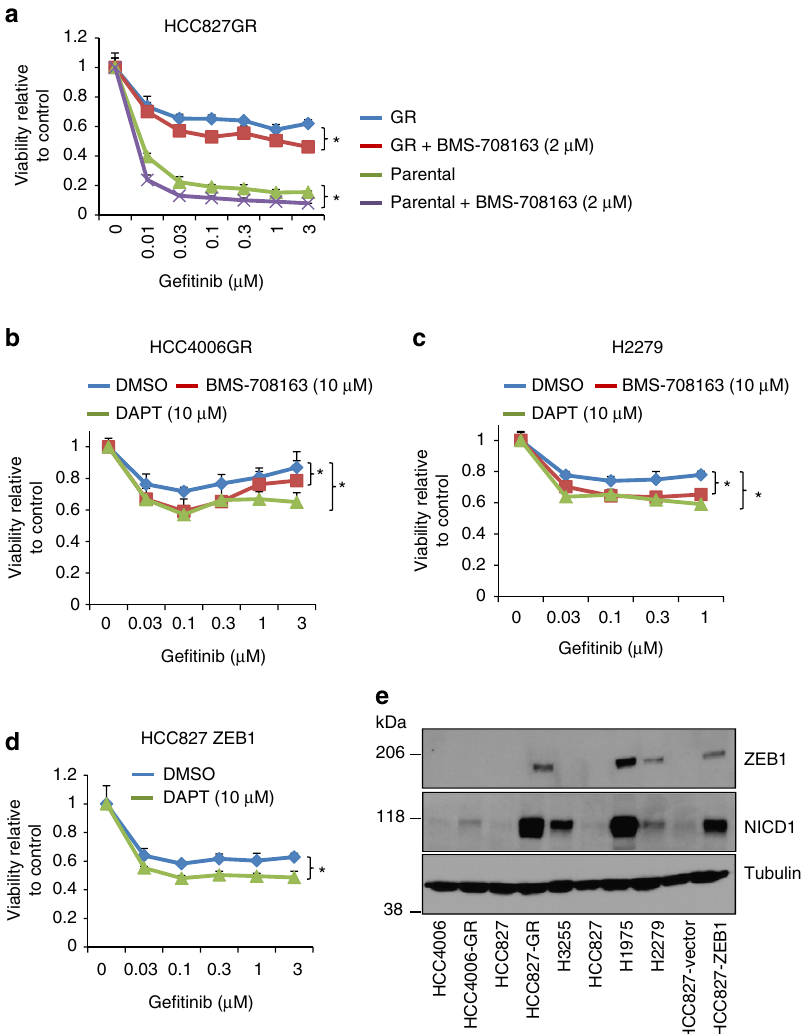
Figure 7 | NOTCH1 promotes gefitinib resistance. ( a ) MTTassay for parental HCC827 and HCC827GR cells treated with or without gefitinib and in the presence or absence of BMS-708163 as indicated (triplicates; mean plus s.d.). ( b – d ) MTTassays for multiple gefitinib-resistant cell lines treated with or without g -secretase inhibitors, including BMS-708163 or DAPTas indicated (triplicates; mean plus s.d.). * in the above figures indicates one-way ANOVA test, P o 0.05. ( e ) Western blotting of ZEB1, NICD1 and Tubulin for lung cancer cell lines that are sensitive or resistant to